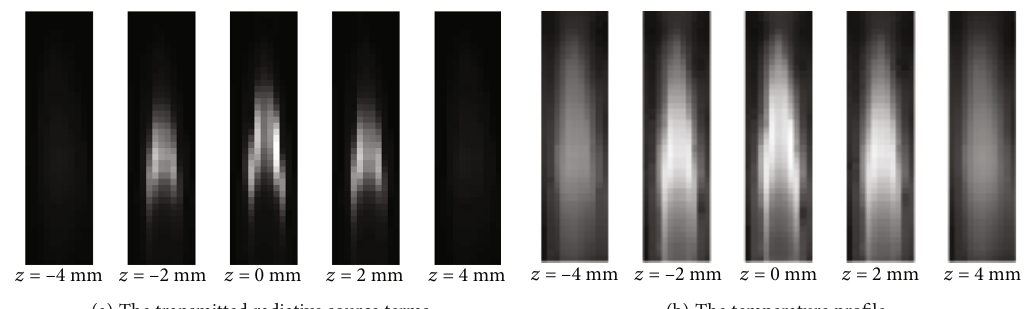
Figure 18: The reconstruction results of the candle fl ame.